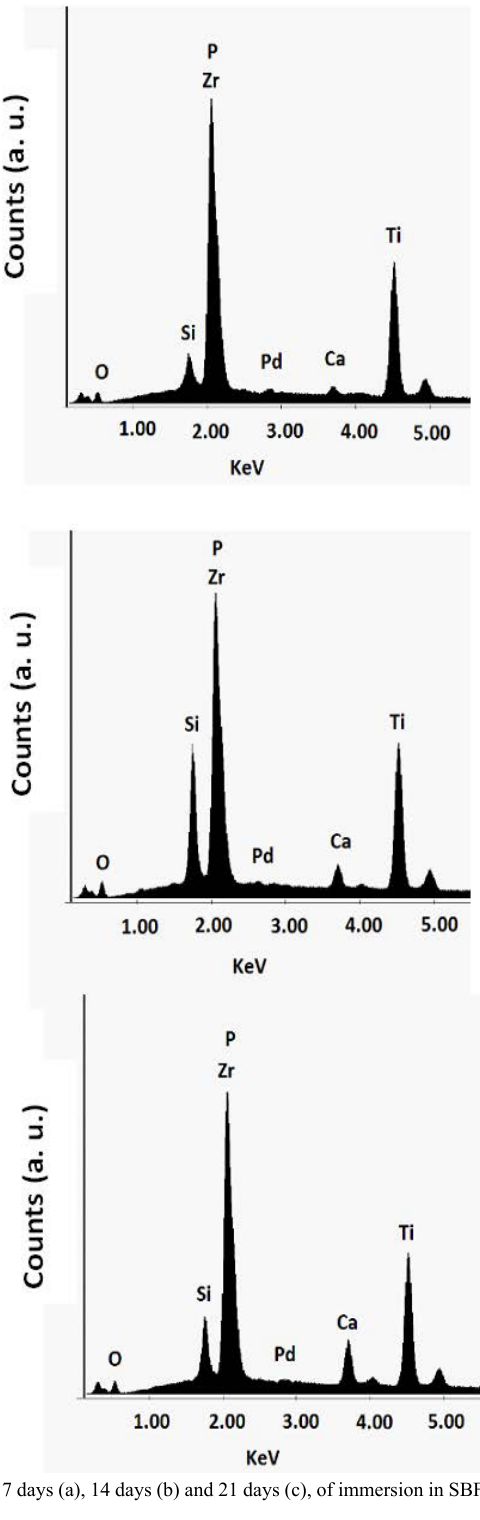
Figure 5. SEM images and EDS spectra of sintered (1500 °C) ZrTiO on a wollastonite powder